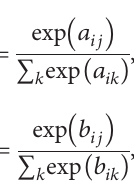
Figure 3: An illustration of attention coefficients’ generation. The edge feature not only serves as local information to center point but also responses the effect of between neighbors and centroid. Edge attention and neighbor attention reflect the important of edge features and neighbor features to centroid,